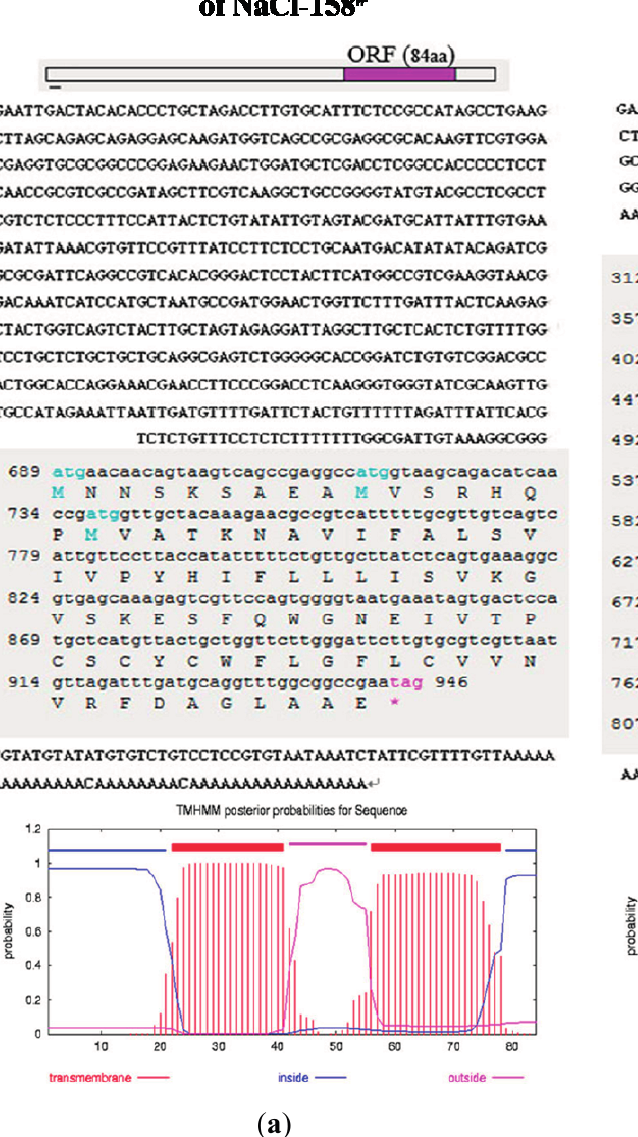
Figure 3. Sequence analysis of NaCl-158 # and NaCl-167 # . ( a ) Open reading frame and transmembrane helix analysis of NaCl-158 # ; ( b ) open reading frame and transmembrane helix analysis of NaCl-167 #